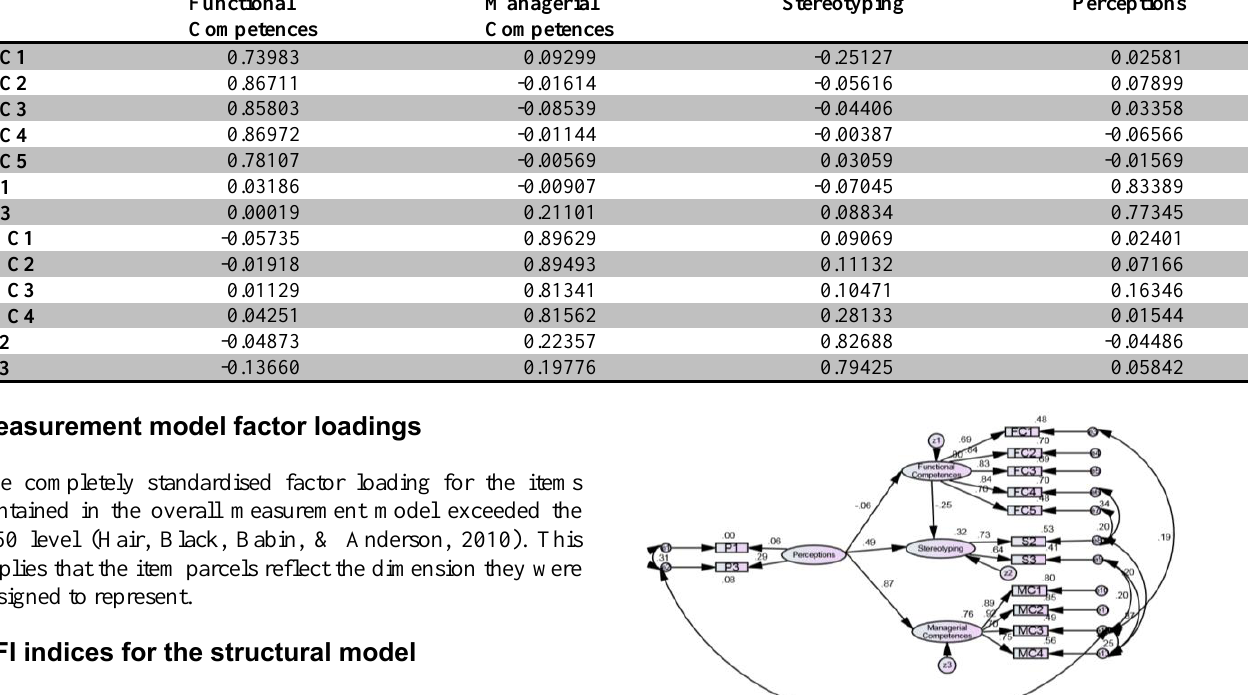
Table 3: Factor loadings (in bold) and cross loadings for each construct and its indicators Functional